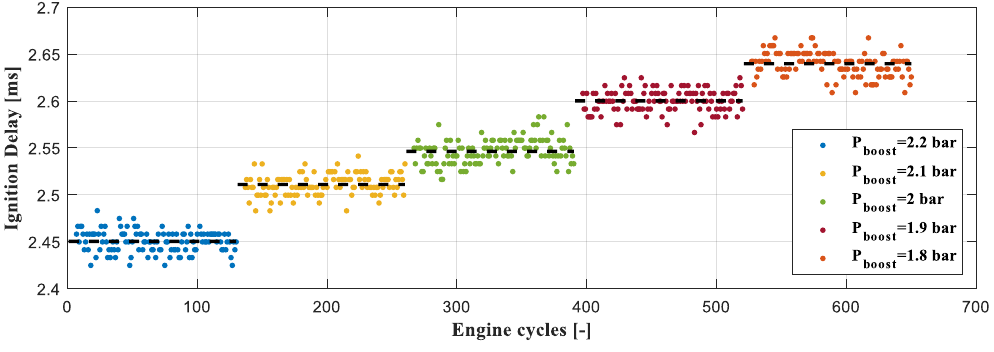
Figure 9. Effect of different intake pressure on ID.